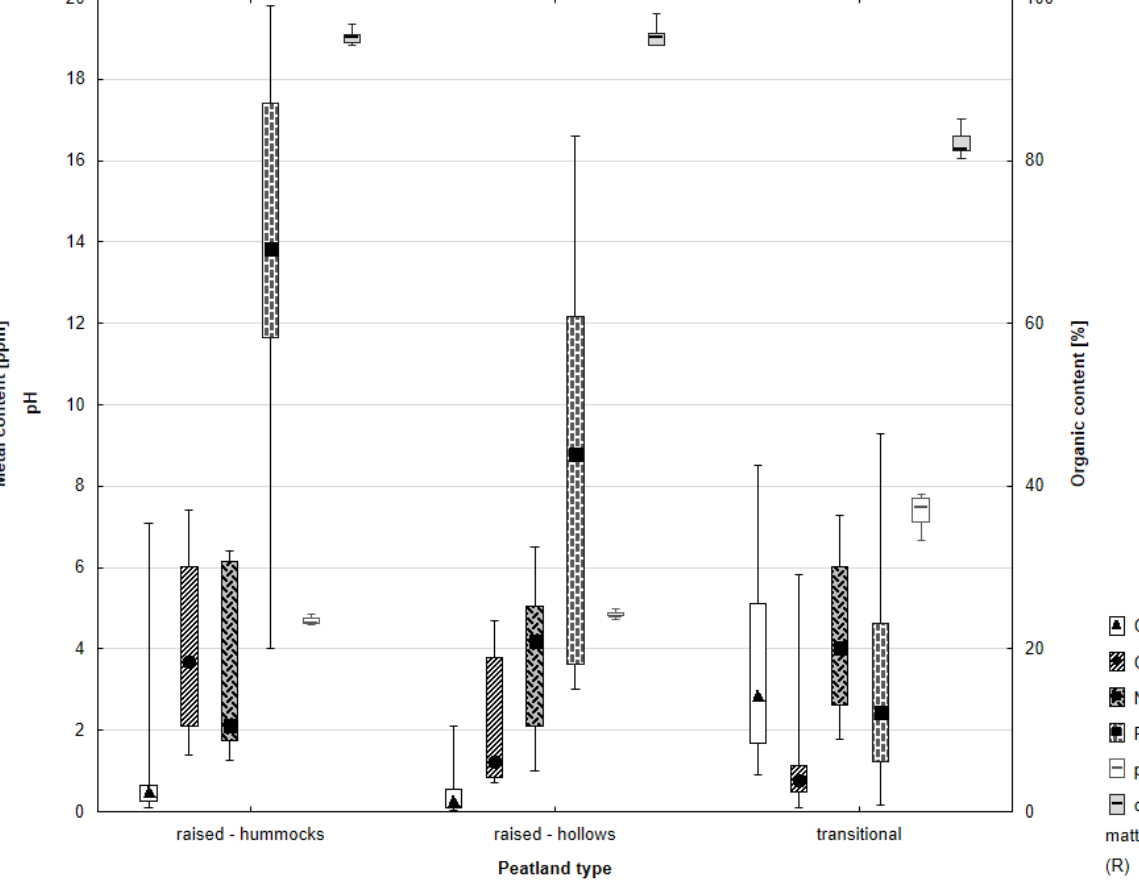
Figure 4. The range of values of the measured trace elements in the three peatland types. Each box indicates